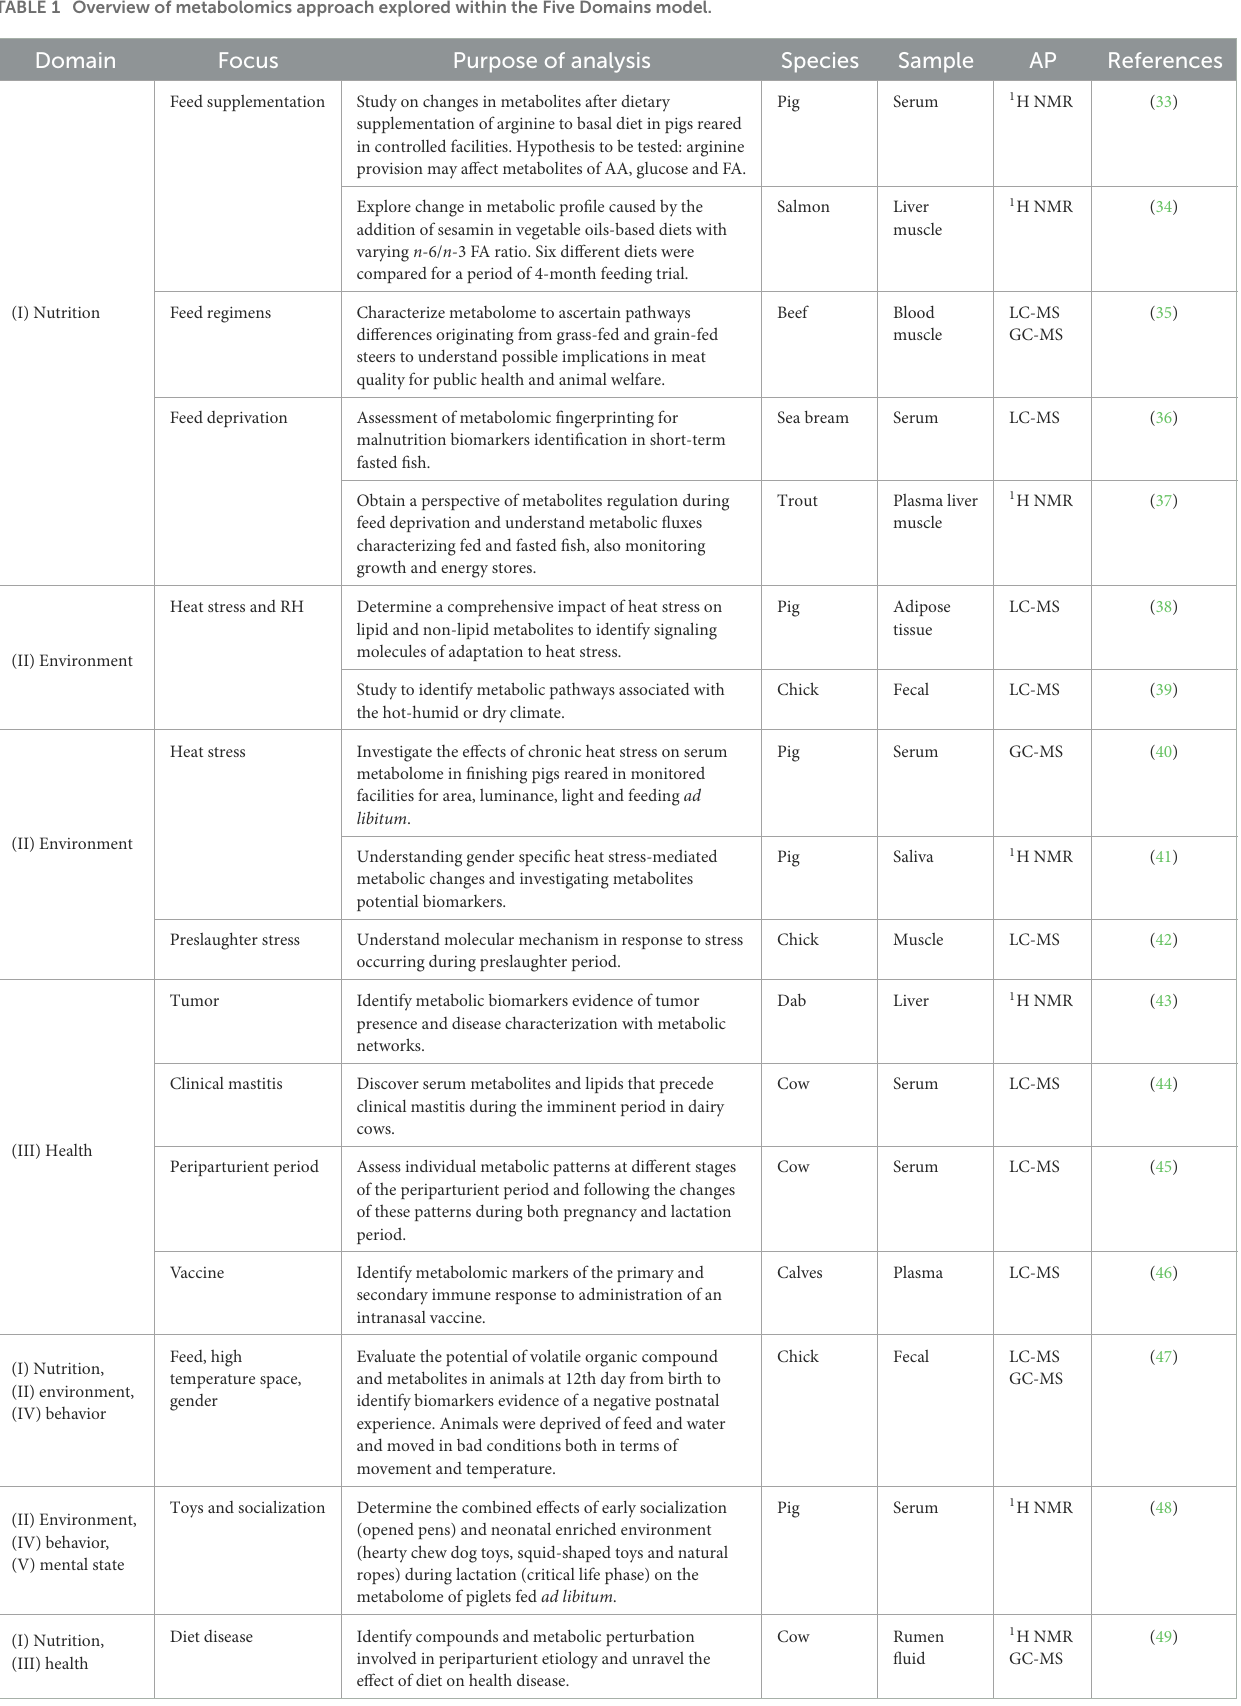
TABLE 1 Overview of metabolomics approach explored within the Five Domains model.